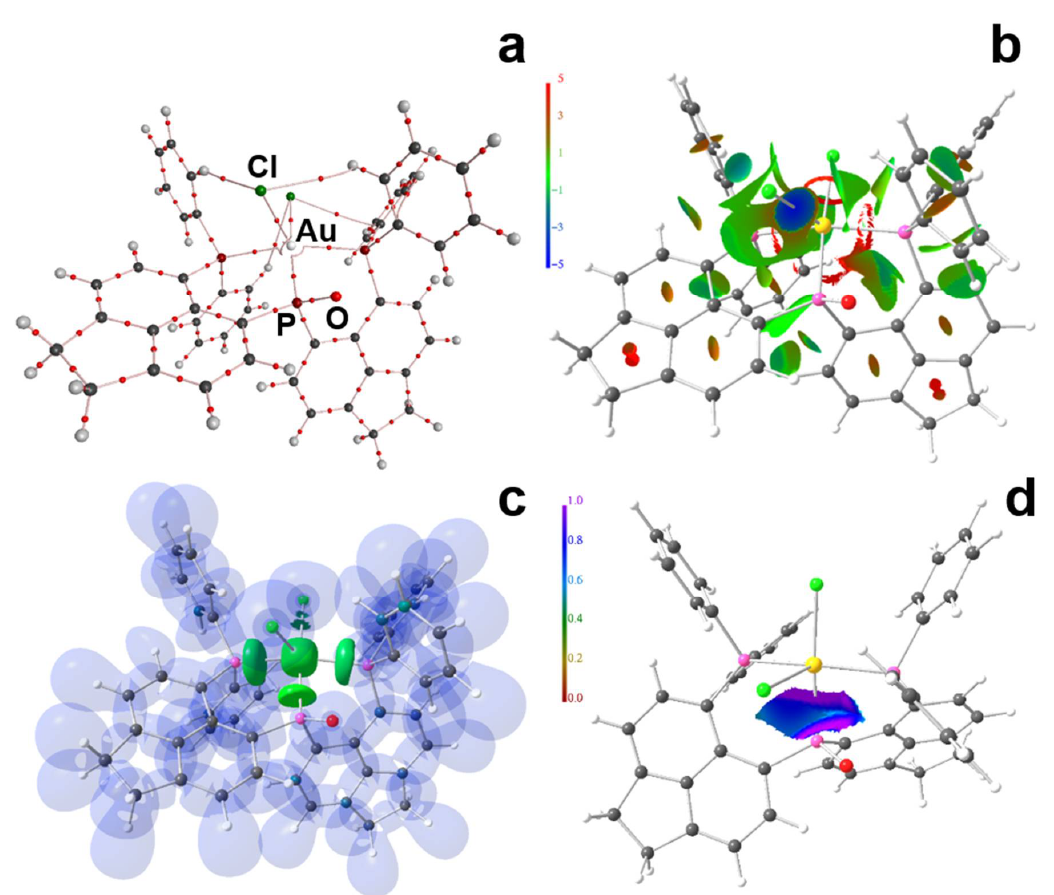
Figure 2. Real-space bonding indicator (RSBI) analysis of 1 ( a ) Atoms-In-Molecules (AIM) molecular graph, ( b ) non-covalent interactions (NCI) on the iso -surface at s( r ) = 0.5 color coded with sign( λ 2 ) ρ (blue = attractive, red = repulsive, green = weak van der-Waals interaction), ( c ) electron localizability locator (ELI-D) localization domain representation at iso -value of 1.3, ( d ) ELI-D distribution mapped on the outer contour of the central P–Au ELI-D bonding basin.